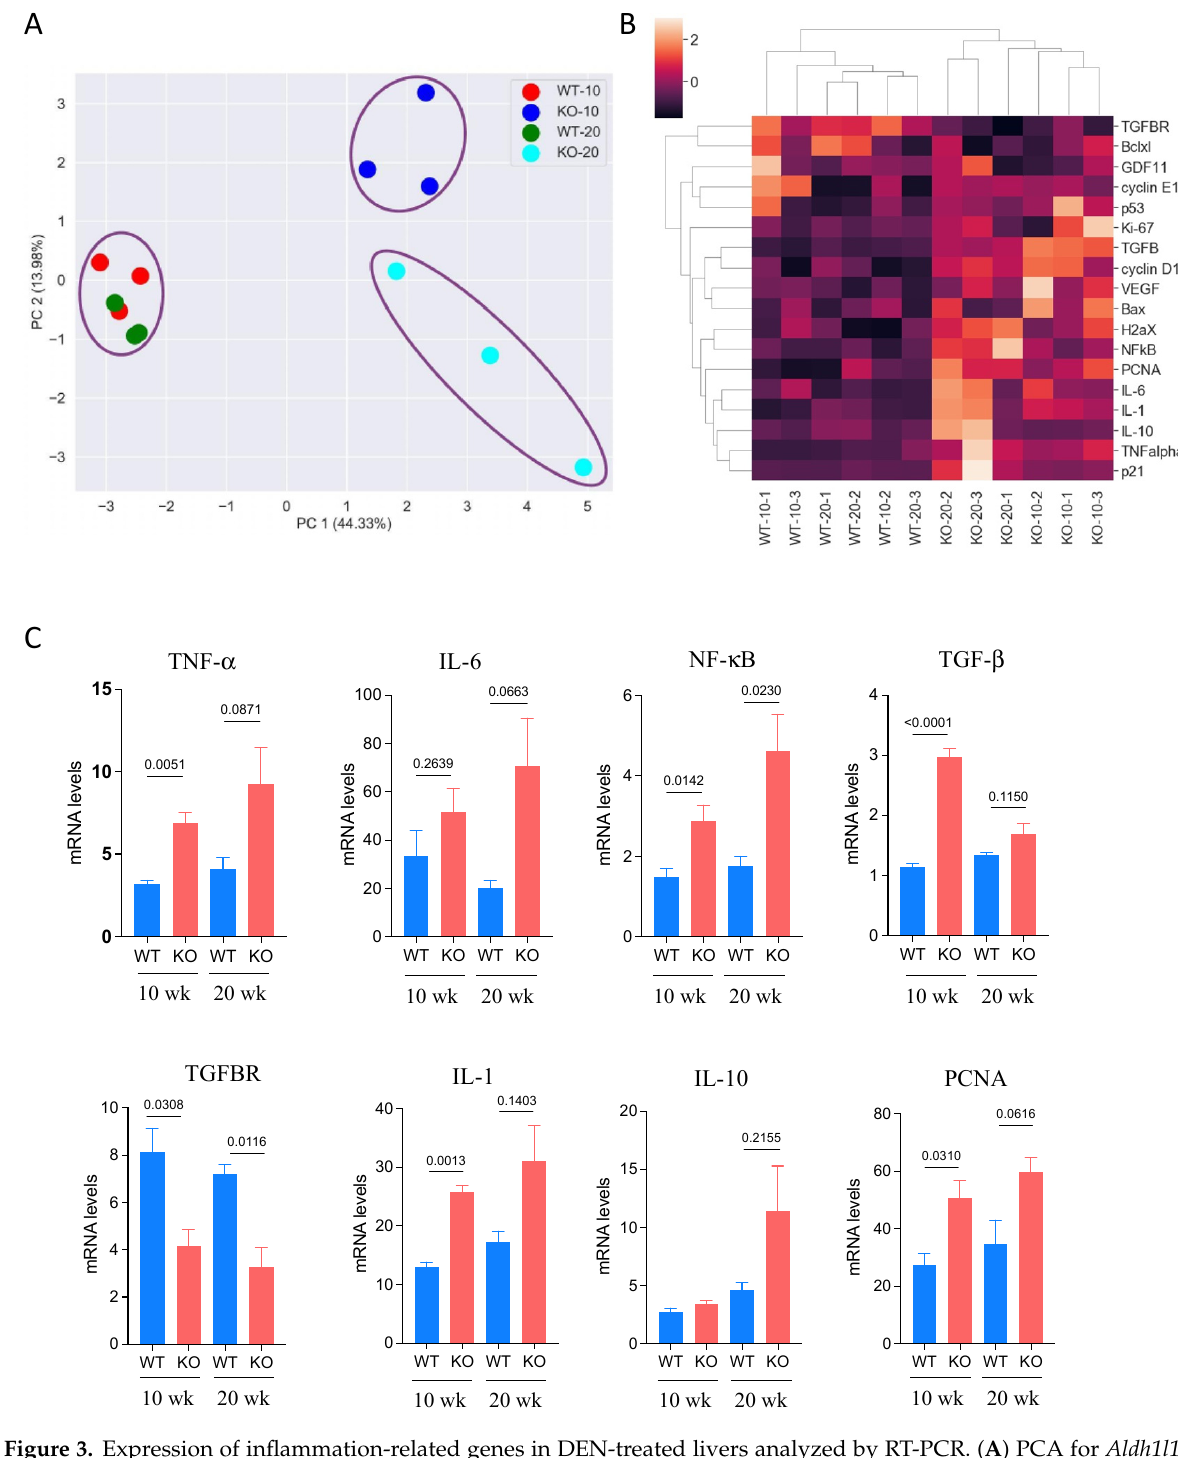
Figure 3. Expression of inflammation-related genes in DEN-treated livers analyzed by RT-PCR. ( A ) PCA for Aldh1l1 +/+ (WT) and Aldh1l − / − (KO) mice carried out using the Python sklearn.decomposition package. The first and second PC of the standardized data explained 44% and 14% of the total variance, respectively. Time points post-DEN injection (10 and 20 weeks) are indicated. ( B ) Standardized RT-PCR data from data pretreatment displayed as a heatmap. The heatmap was produced using the Python seaborn package. Three mice per group (four groups, two genotypes/two time points) were analyzed. ( C ) Relative levels (RT-PCR) of specific targets.